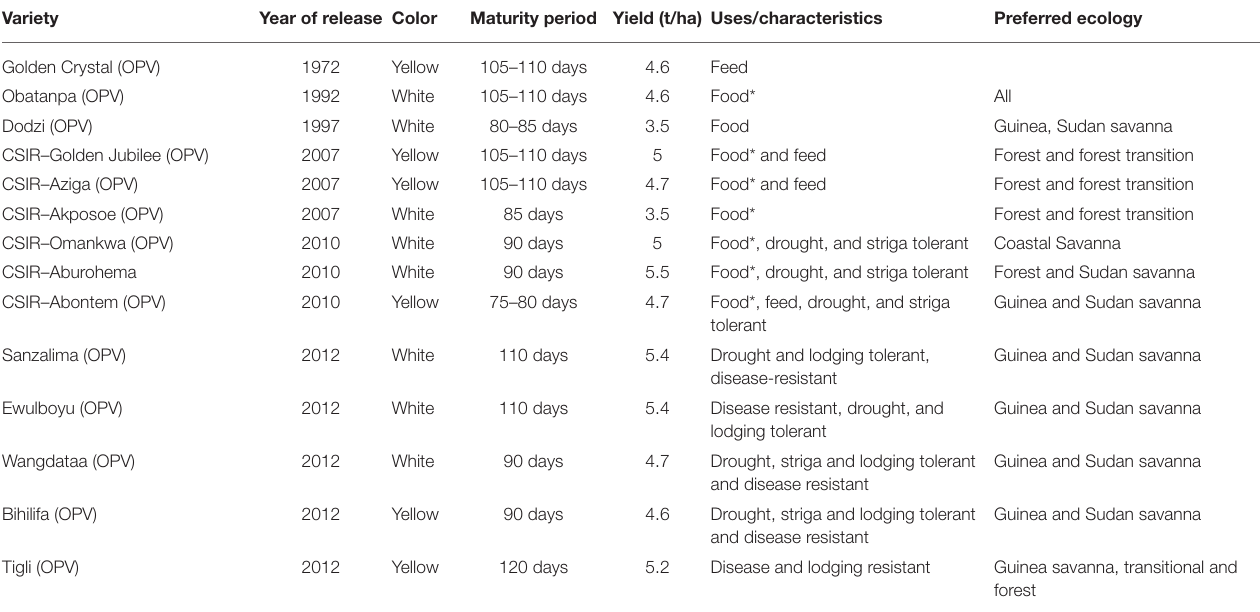
TABLE 2 | Open pollinated maize variety released in Ghana.